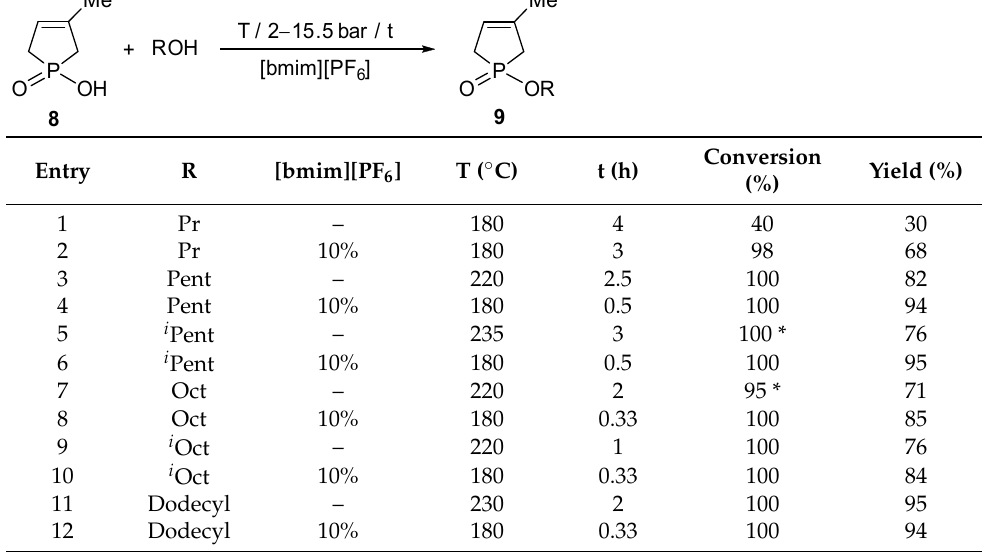
Table 1. Esterification with other alcohols.